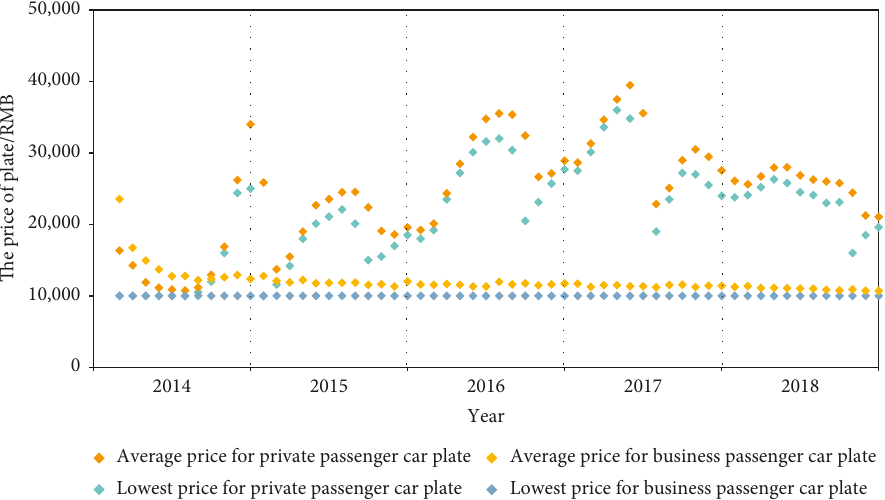
Figure 6: Price of private and business plates in Tianjin by auction.